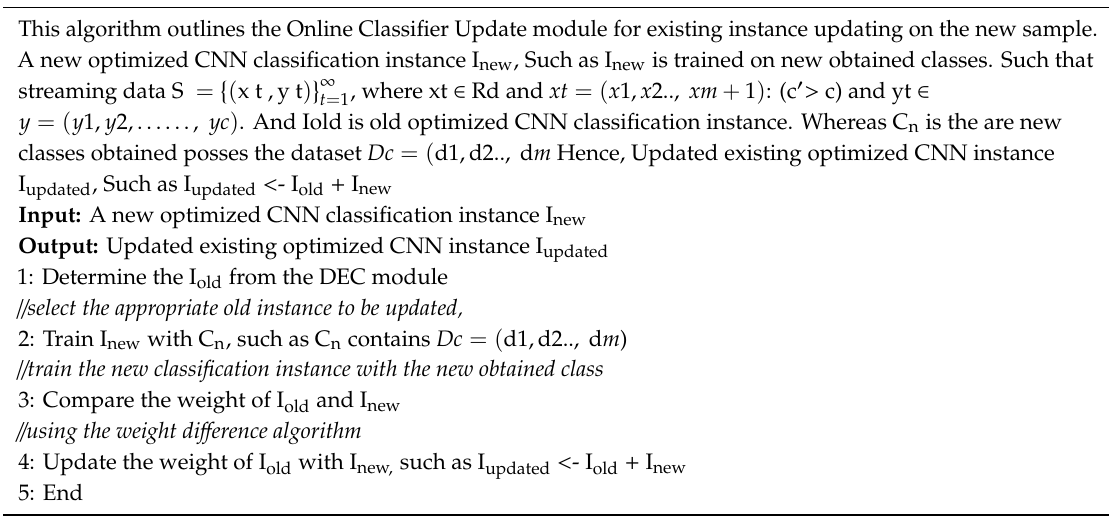
Algorithm 3: Online Classifier Update Module of Ameliorate Adaptive CNN Ensemble